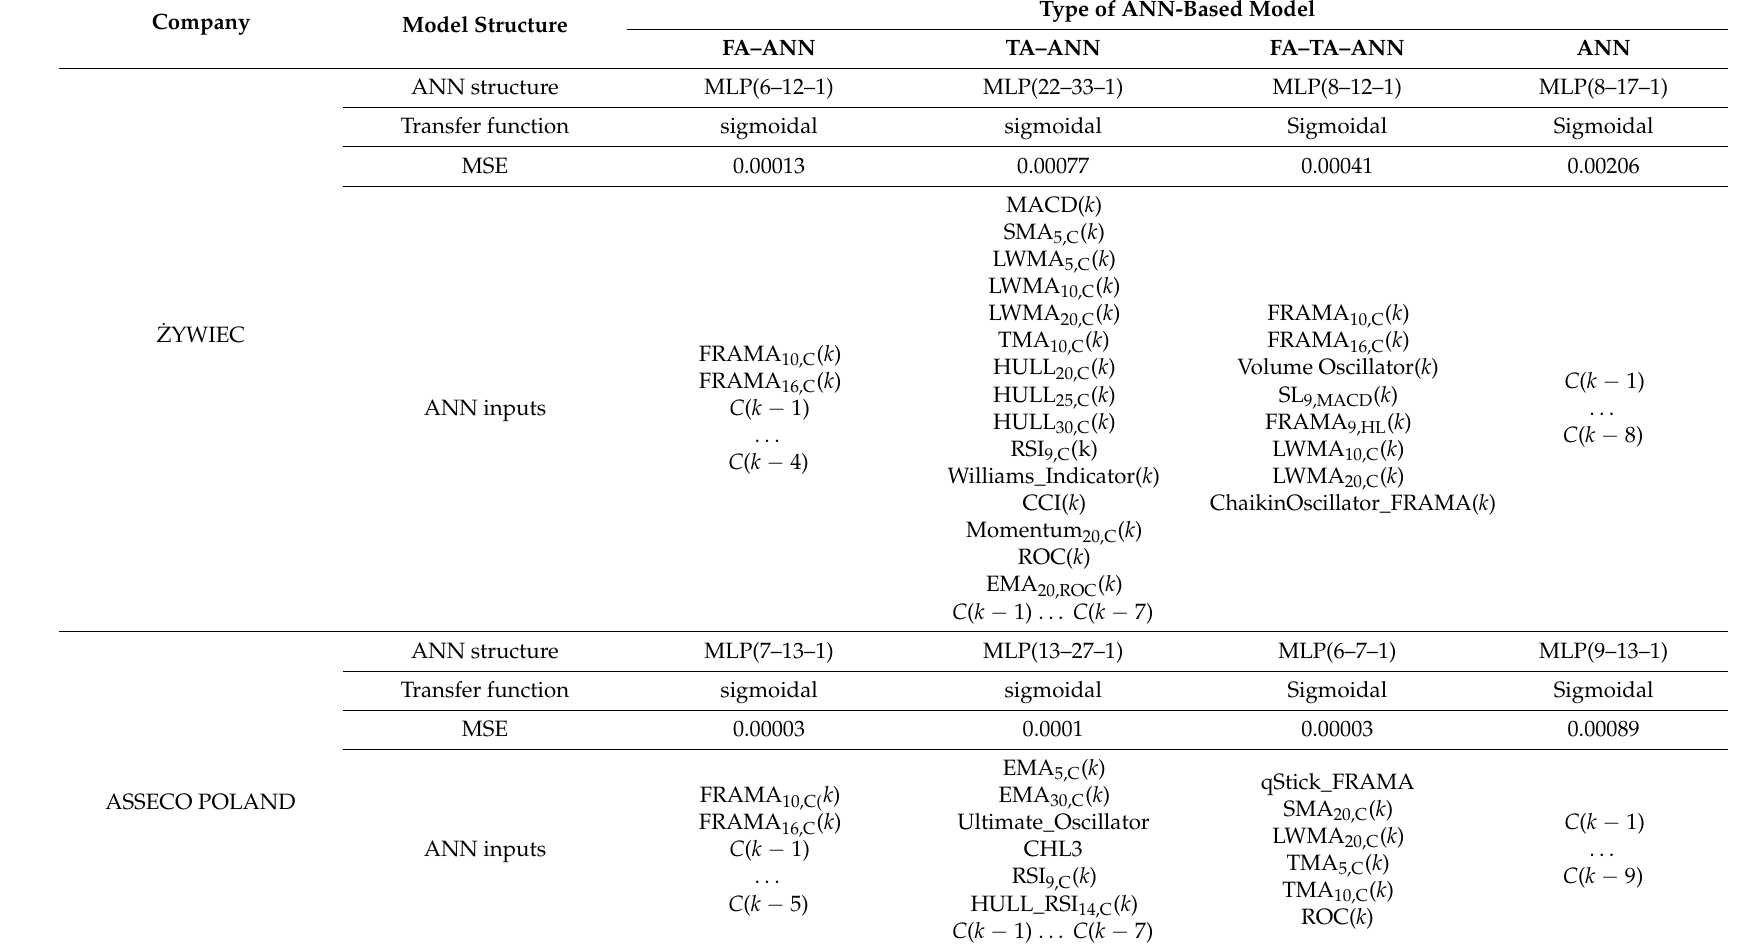
Table 1. Selected ANN-based models: best prediction results for testing